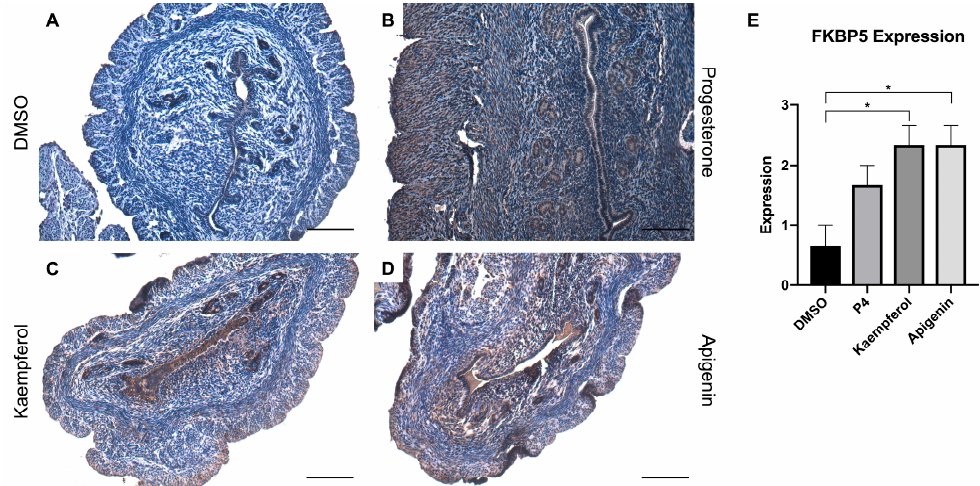
Figure 3. Kaempferol and apigenin increased FKBP5 expression in mouse uteri. Immunohistochem- ical staining against progesterone receptor target FKBP5 on uterine cross sections of control- ( A ), progesterone- ( B ), kaempferol- ( C , D ) apigenin-treated mice. Scale bar = 100 µ m; magnification 20×. ( E ) Quantification of FKBP5 expression per treatment in representative images. One-way ANOVA test was used to determine significance (* p < 0.05).